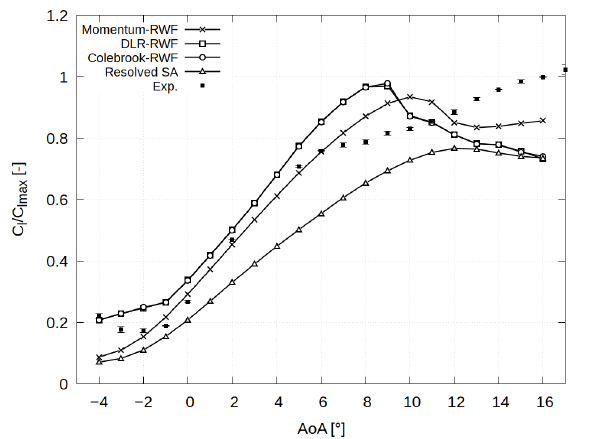
Figure 13. Case 3: C l vs AoA for different wall functions.